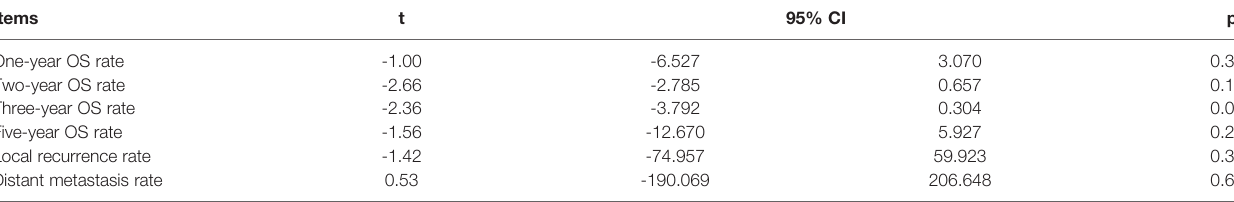
TABLE 6 | Publication bias results of selected articles (CCRT-CCT vs . CCRT